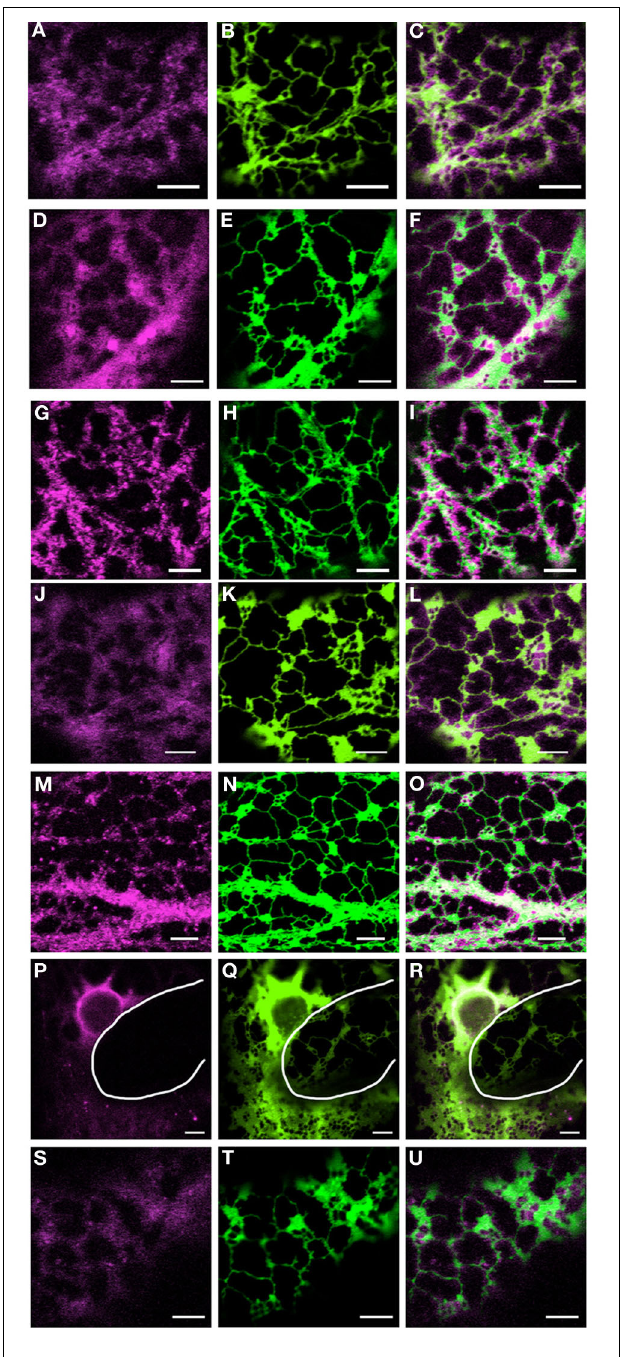
FIGURE 1 | Coexpression of myosin tail domains with an ER marker. Representative images of cells coexpressing GFP-HDEL (green) and mRFP myosin tail domain fusions [magenta; XI-A, (A–C) ; XI-1, (D–F) ; XI-2, (G–I) ; XI-C, (J–L) ; XI-E, (M–O) ; XI-I, (P–R) ; XI-K, (S–U) ]. White line in panels (P–R) highlights the cell boundary between neighboring cells. Scale bar 5 µ